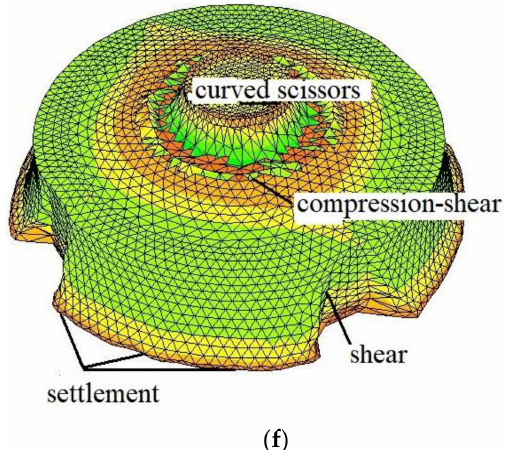
Figure 9. Distribution of plastic zone under various working conditions: ( a ) Without considering wind load, creep, and fracture; ( b ) considering wind load without creep and fracture; ( c ) considering wind load creep without fracture ( t = 18 h); ( d ) considering creep fracture under wind load ( t 0 = 26.2 h); ( e ) considering creep fracture under wind load ( t F = 27.1 h); ( f ) the creep fracture failure modes under wind load are considered ( t F = 27.1